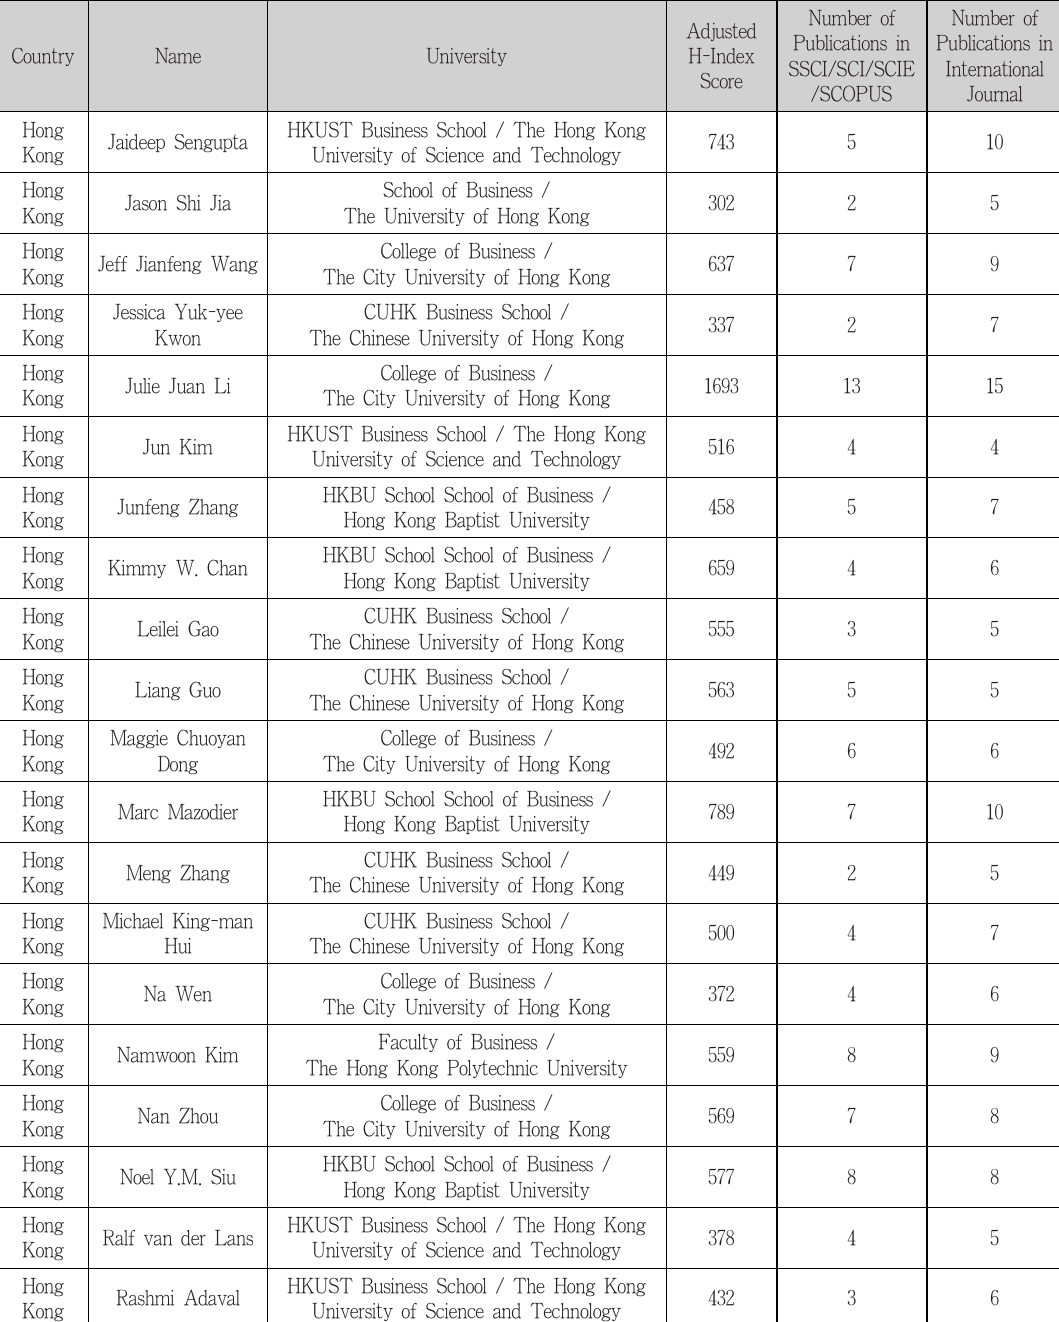
<Table 1> 100 Research-Active Scholars in Asia